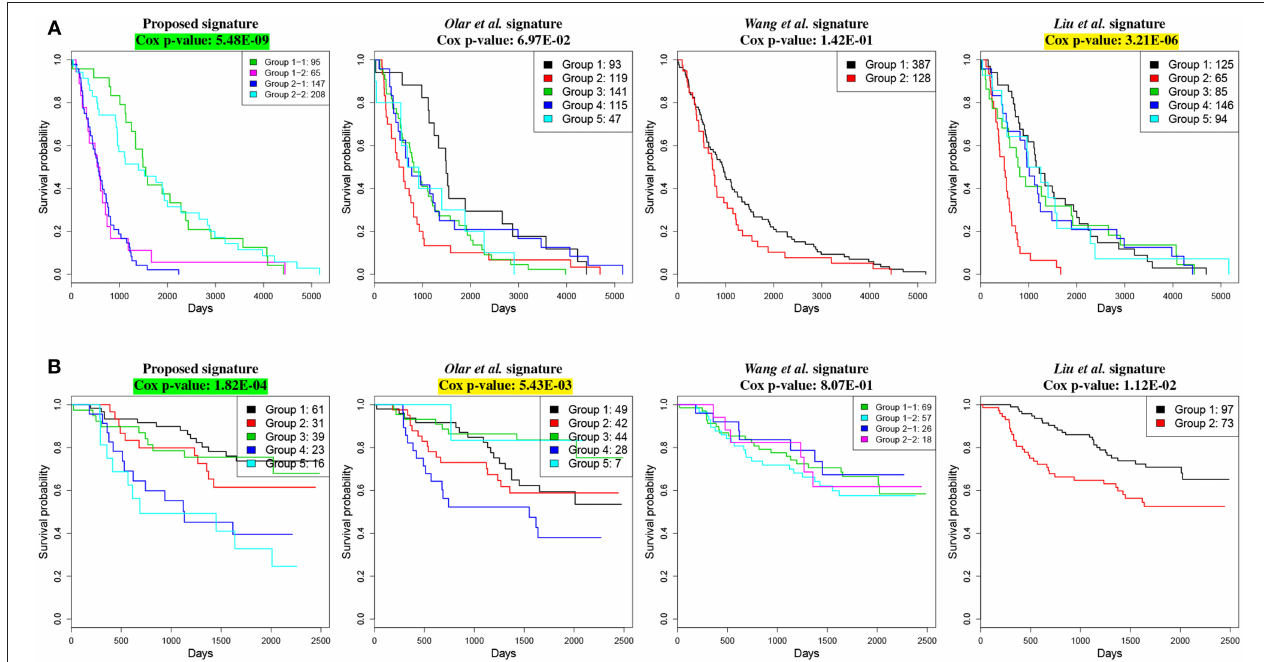
FIGURE 5 | Kaplan–Meier survival analysis on LGG studies, using different gene signature panels. (A) TCGA dataset which contains gene expression profiles from 515 individual patients. (B) CGGA dataset which contains gene expression profiles from 170 individual patients. The horizontal axes represent the time (in days) from the start of the study, whereas the vertical axes represent estimated survival percentage. Yellow colors represent the Cox p -values that are significant ( < 0.01). The green color indicates the best signature (i.e., lowest Cox p -value) for the given dataset. These results show that the proposed signature yields the best separation between aggressive and less aggressive disease on both datasets.